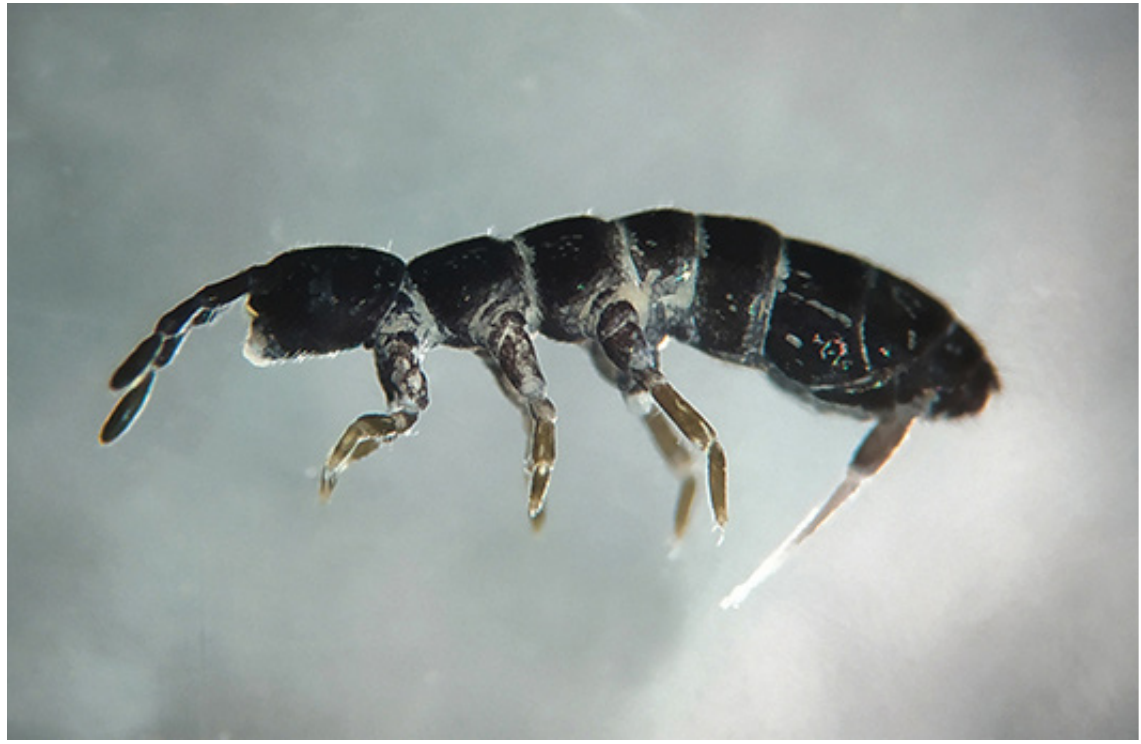
Fig. 1. Desoria calderonis sp. nov., general